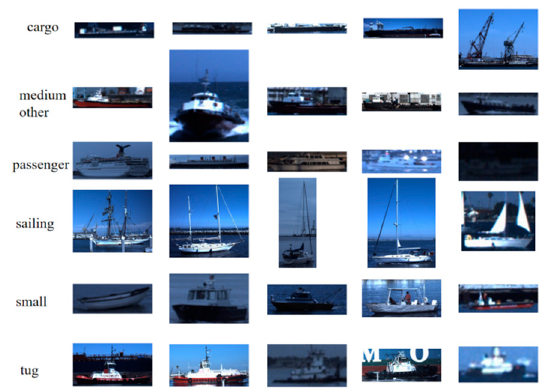
Figure 4. Some visible image of VAIS dataset.